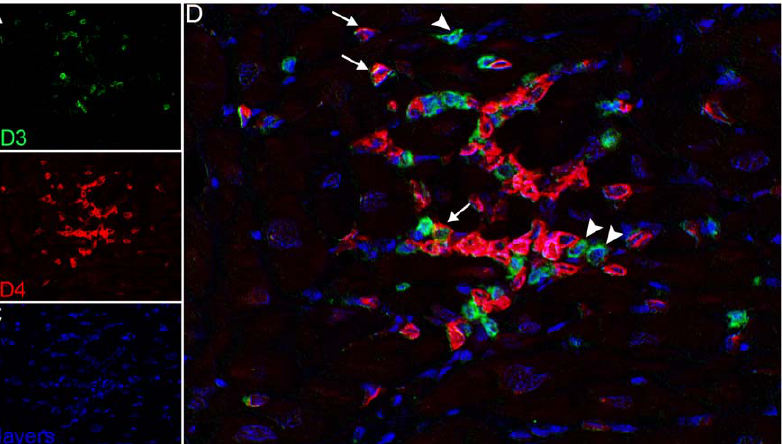
Figure 5. Lesions are composed of lymphocytes and macrophages. Double immunolabeling and spectral imaging with pseudofluorescence coloring identifies CD4 + T-lymphocytes and macrophages (red) within inflammatory foci (B). Expression of CD3 (green) identifies lymphocytes within inflammatory foci (A). Nuclei are stained with Mayer’s hematoxylin (blue) (C). CD4 + lymphocytes express both CD4 and CD3 molecules (arrows) (D). Note CD3 expression on cells that do not express CD4